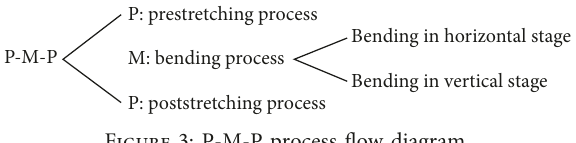
Figure 3: P-M-P process flow diagram.